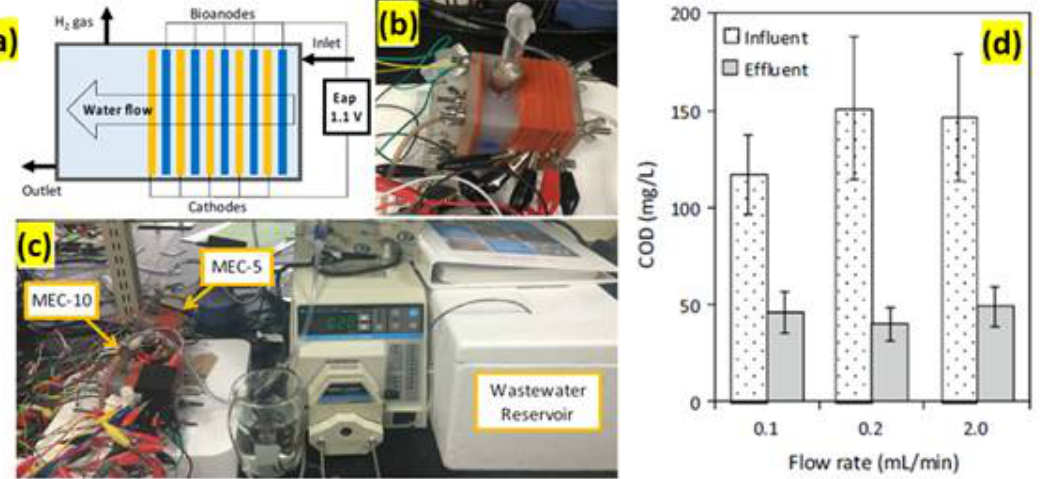
Figure 9. Sandwiched electrode stack system: ( a ) schematic of the sandwiched electrode stack, ( b ) MEC-5, ( c ) continuous-flow system with MEC-10 and MEC-5 in sequence, and ( d ) plot of the increase in the COD vs. flow rate. Wastewater treatability of the MEC system: COD removal. (Adopted from Ref [69], open access.).